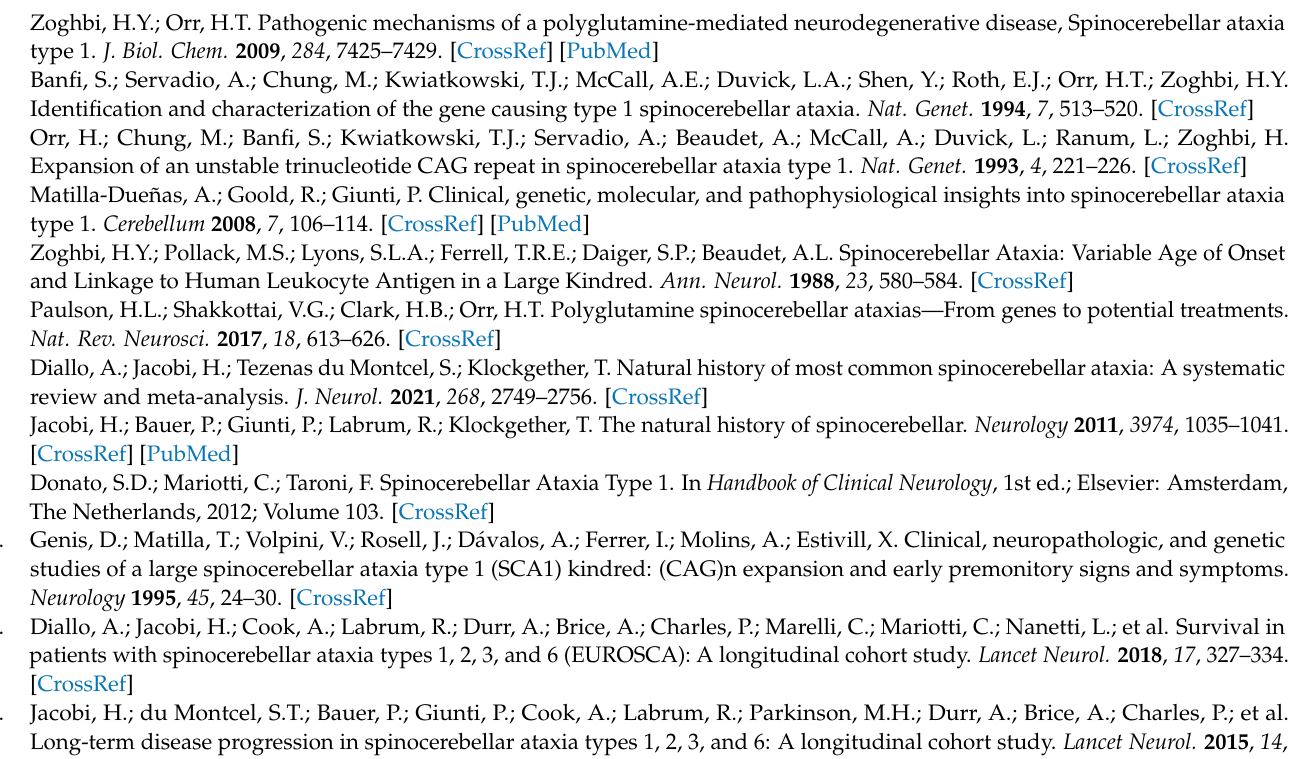
have loxP sites surrounding the STOP codon in front of the TdTomato gene. TMX injection re- sulted in TdTomato signal in astroglial cells, marked by expression of S100B. Figure S3. Represen- tative GFAP immunofluorescence staining in the cerebellar molecular layer of 22–26-week-old mice. Figure S4. Representative VGLUT2 (green) and calbindin (red) immunofluorescence staining in the cere- bellar molecular layer of 12-week-old mice. Figure S5. Purkinje cell number is not altered in ATXN1[71Q] mice. Image J was used to quantify the number of calbindin-positive Purkinje cells at 22–26 weeks. Data are presented as mean ± SEM with average values for each mouse represented by a dot. No statistical differences using one-way ANOVA with Bonferroni’s multiple comparison test. Error bars =